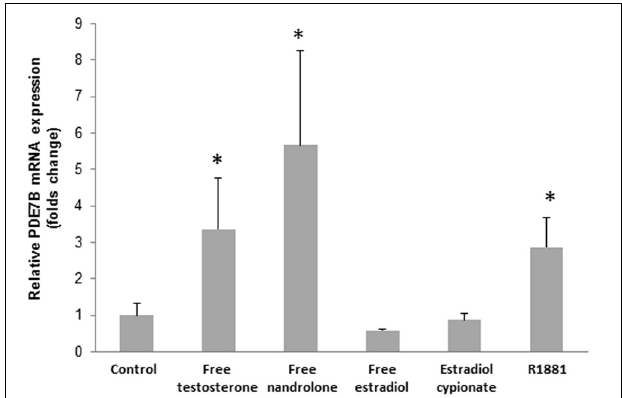
FIGURE 3 | PDE7B mRNA expression in HepG2 cells after 2h incubation with 1 µ M of various hormones (free testosterone, nandrolone, and estrogen, estradiol cypionate, and R1881). The androgens but not the estrogens induced the PDE7B gene expression. ∗ p < 0 .